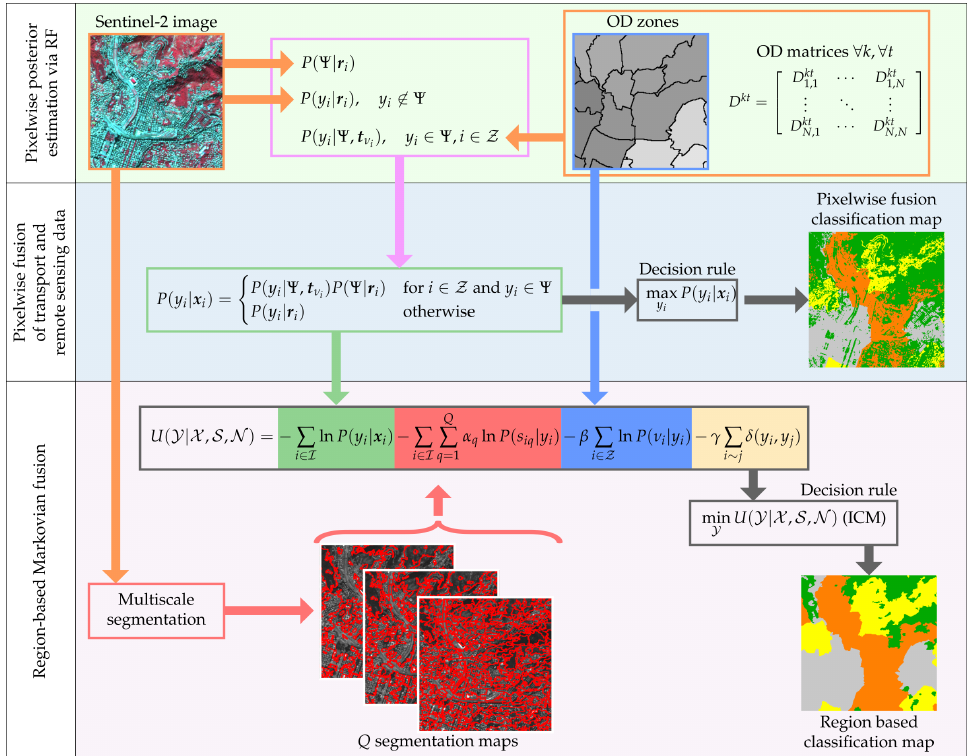
Figure 6. Block diagram of the two proposed methodologies: posterior probability estimation (light green box), pixelwise decision fusion (light blue box), and multiscale region-based Markovian fusion (light red